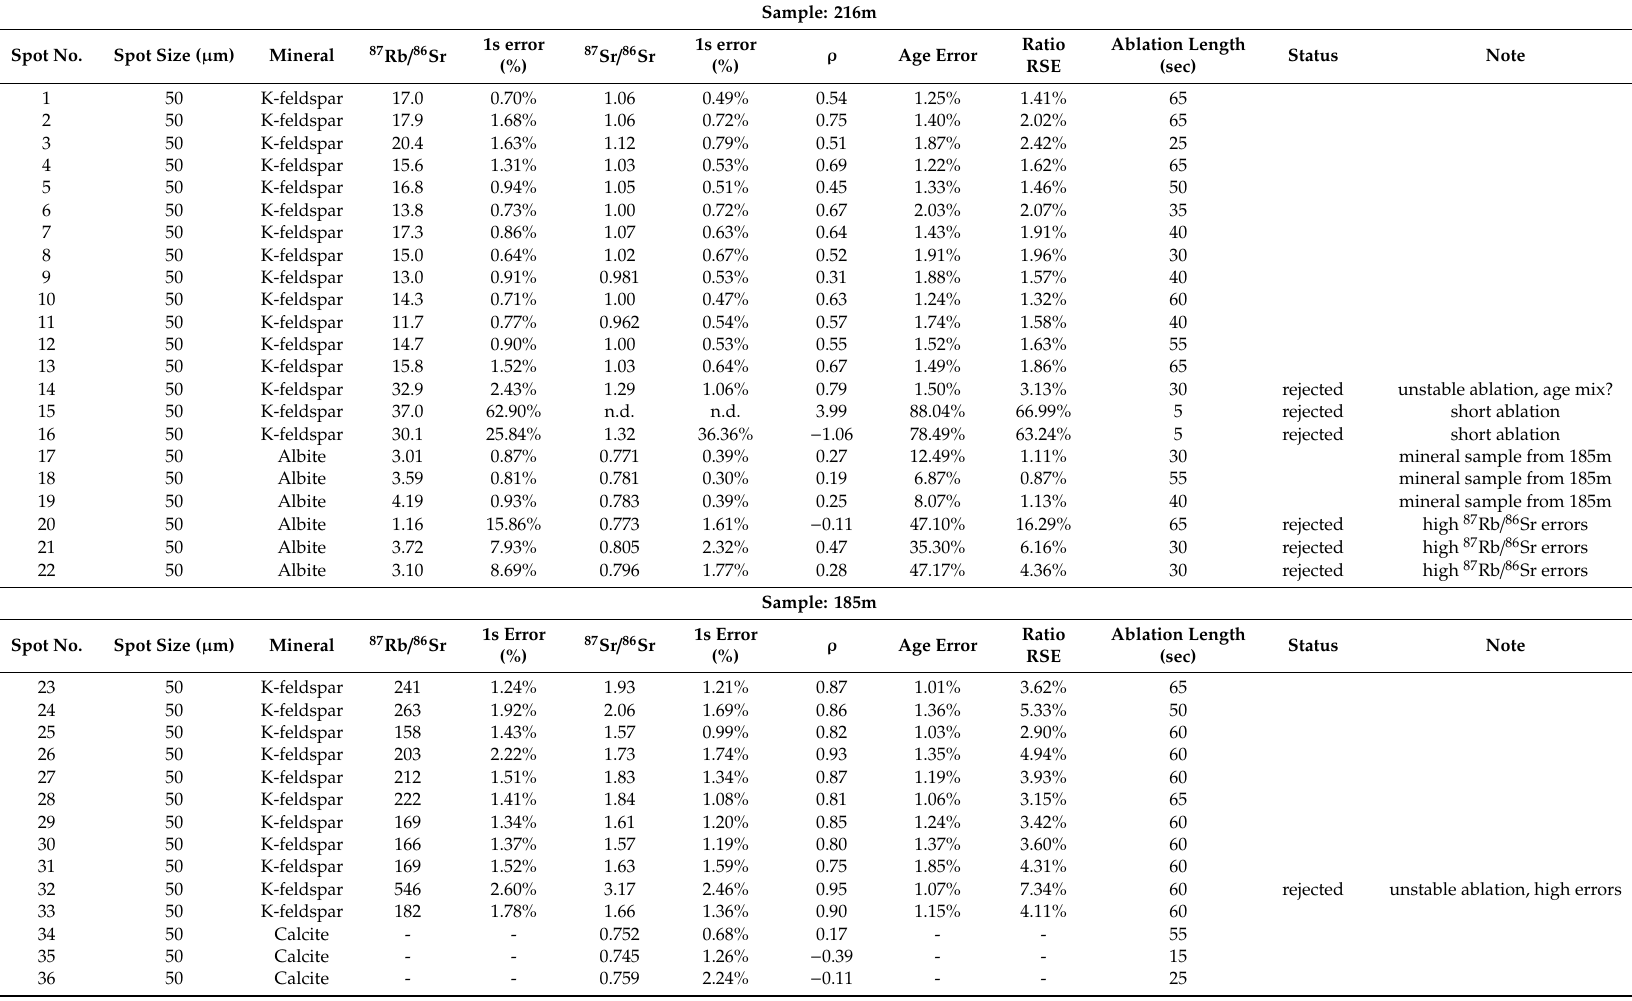
Table 4. LA-ICP-MS in situ Rb-Sr data of samples 216m and 185m. nd = not